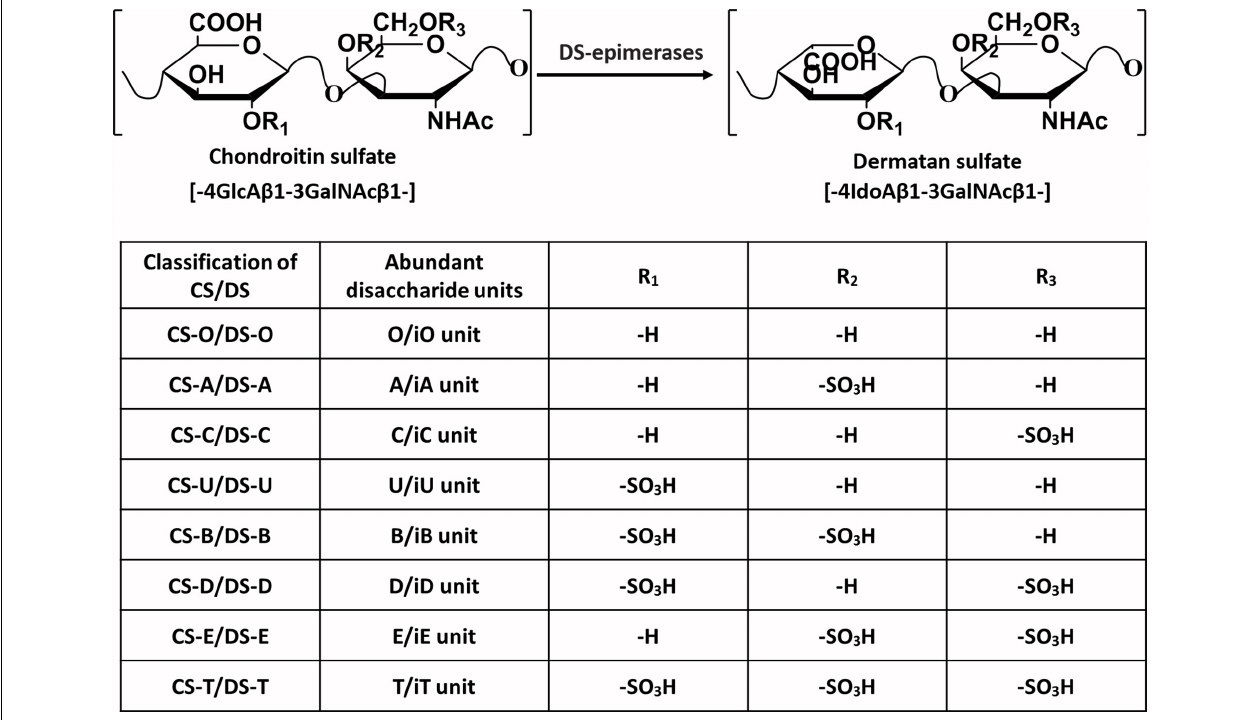
Frontiers in Cell and Developmental Biology |